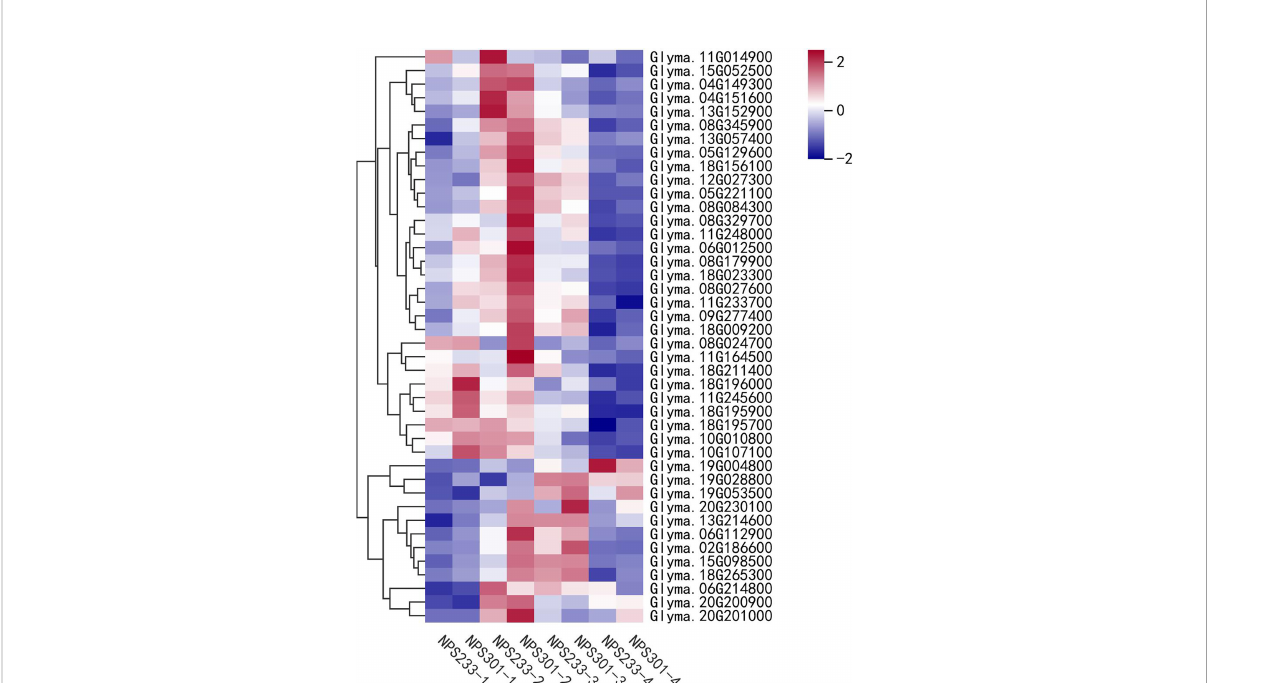
FIGURE 4 Expression patterns of DEGs involved in lipid biosynthesis and signal transduction pathways in soybean seed development. Heatmap showing the expression patterns of the candidate genes involved in the regulation of oil content accumulation in soybean seed. Glyma.11G014900 , acyl CoA binding protein; Glyma.15G052500 , hydroxyacyl-ACP dehydrase; Glyma.04G149300 , ketoacyl-CoA synthase; Glyma.04G151600 , fatty acyl thioesterase B; Glyma.13G152900 , acyl CoA binding protein; Glyma.08G345900 , enoyl-ACP reductase; Glyma.13G057400 , heteromeric acetyl